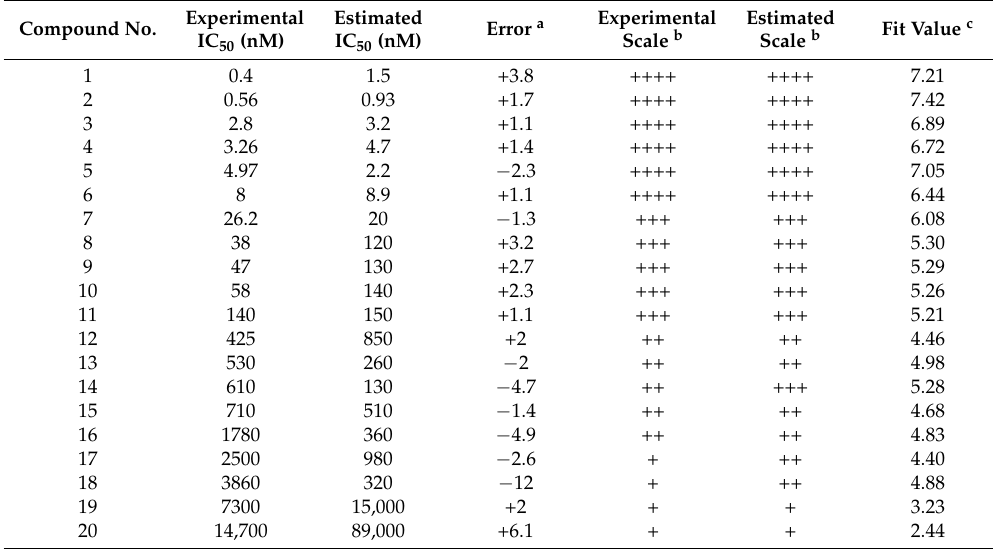
Table 2. Experimental and estimated IC 50 values of the training set using the best hypothesis, Hypo 1. Compound No.